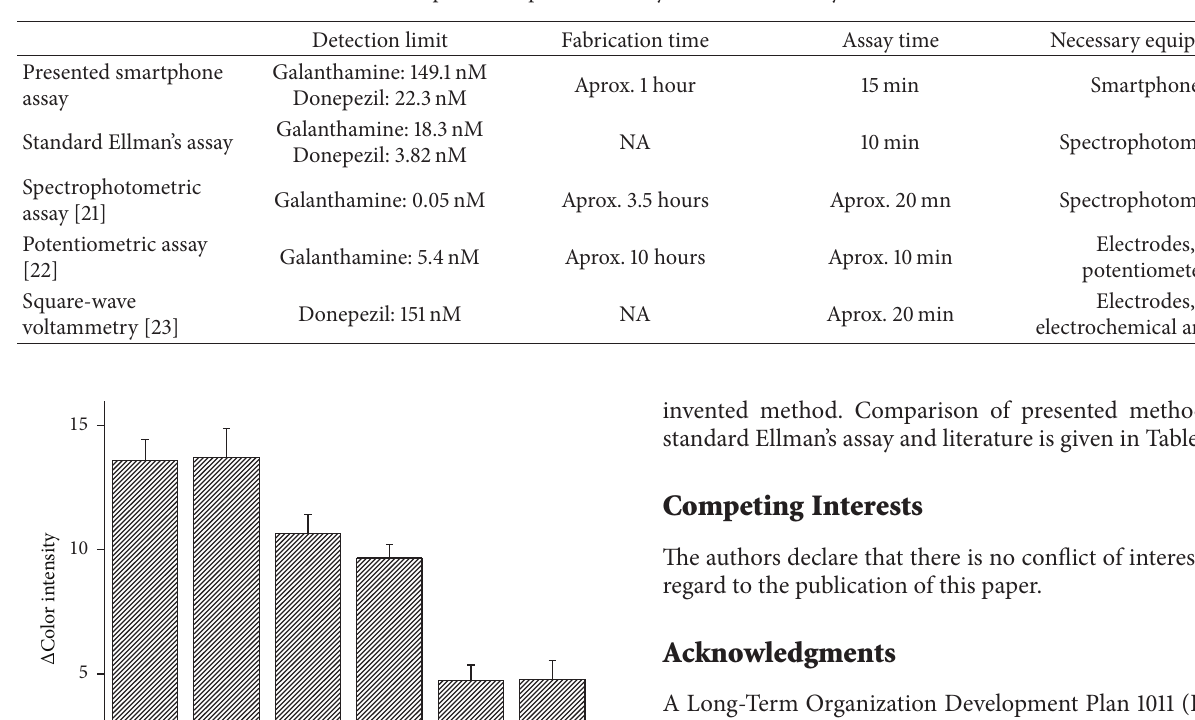
Table 1: Comparison of presented assay with Ellman’s assay and literature.